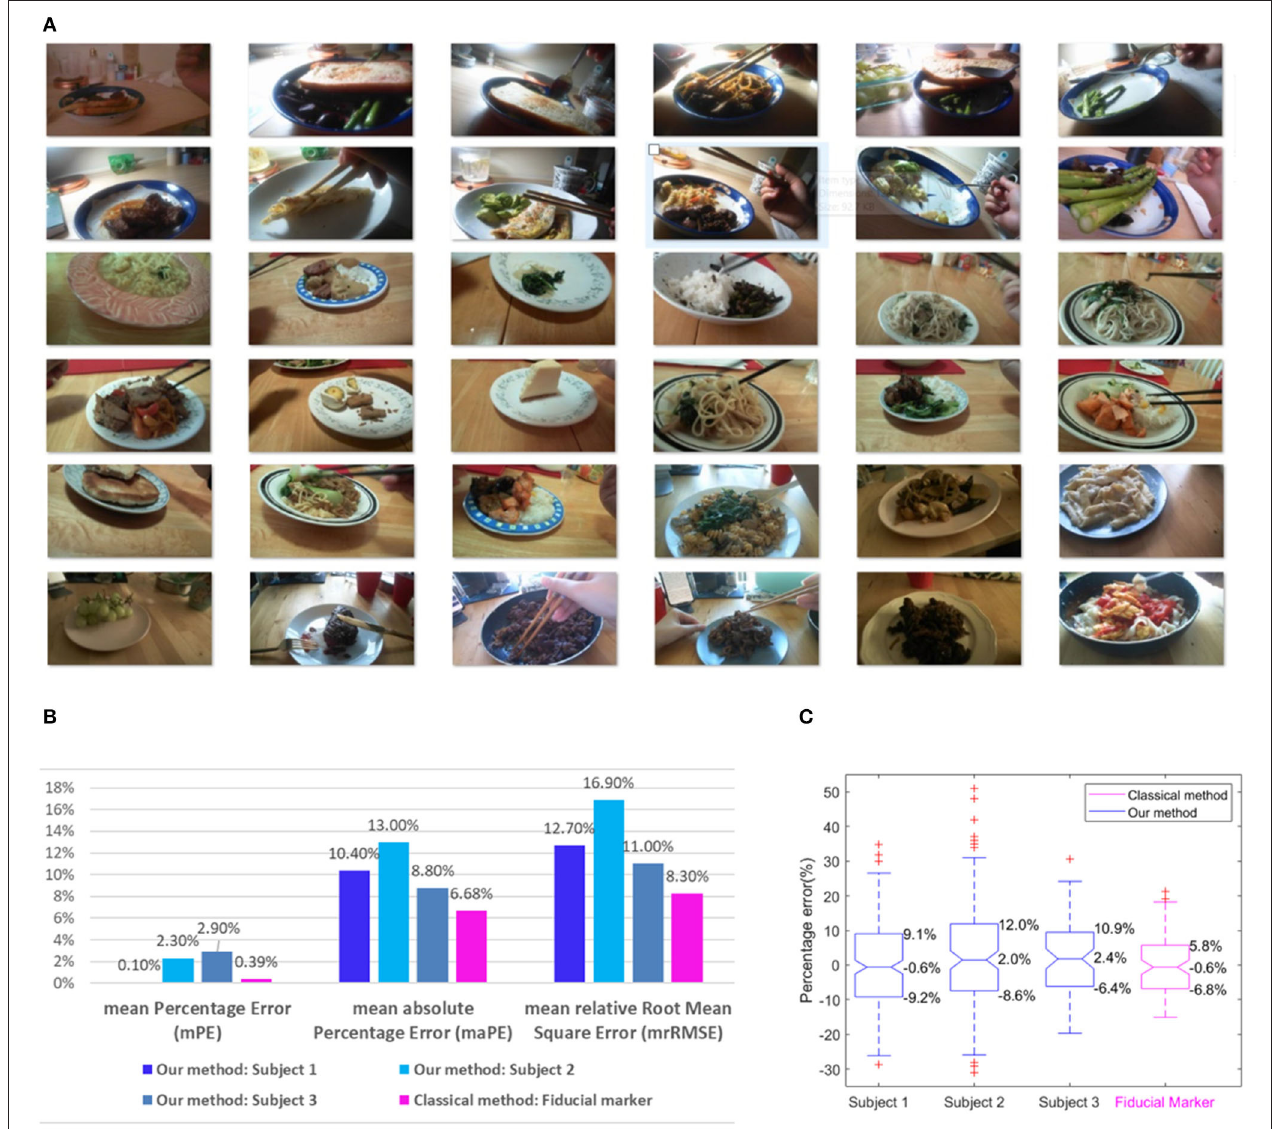
FIGURE 3 | (A) Illustrations of one typical image for each episode; (B) Calculated mPE, maPE, and mrRMSE for each subject and the fiducial marker method; (C) Box-plot of percentage errors for each subject with extreme percentage errors, 25th percentiles of errors, median, and 75th percentiles of errors marked for the three subjects and the fiducial marker